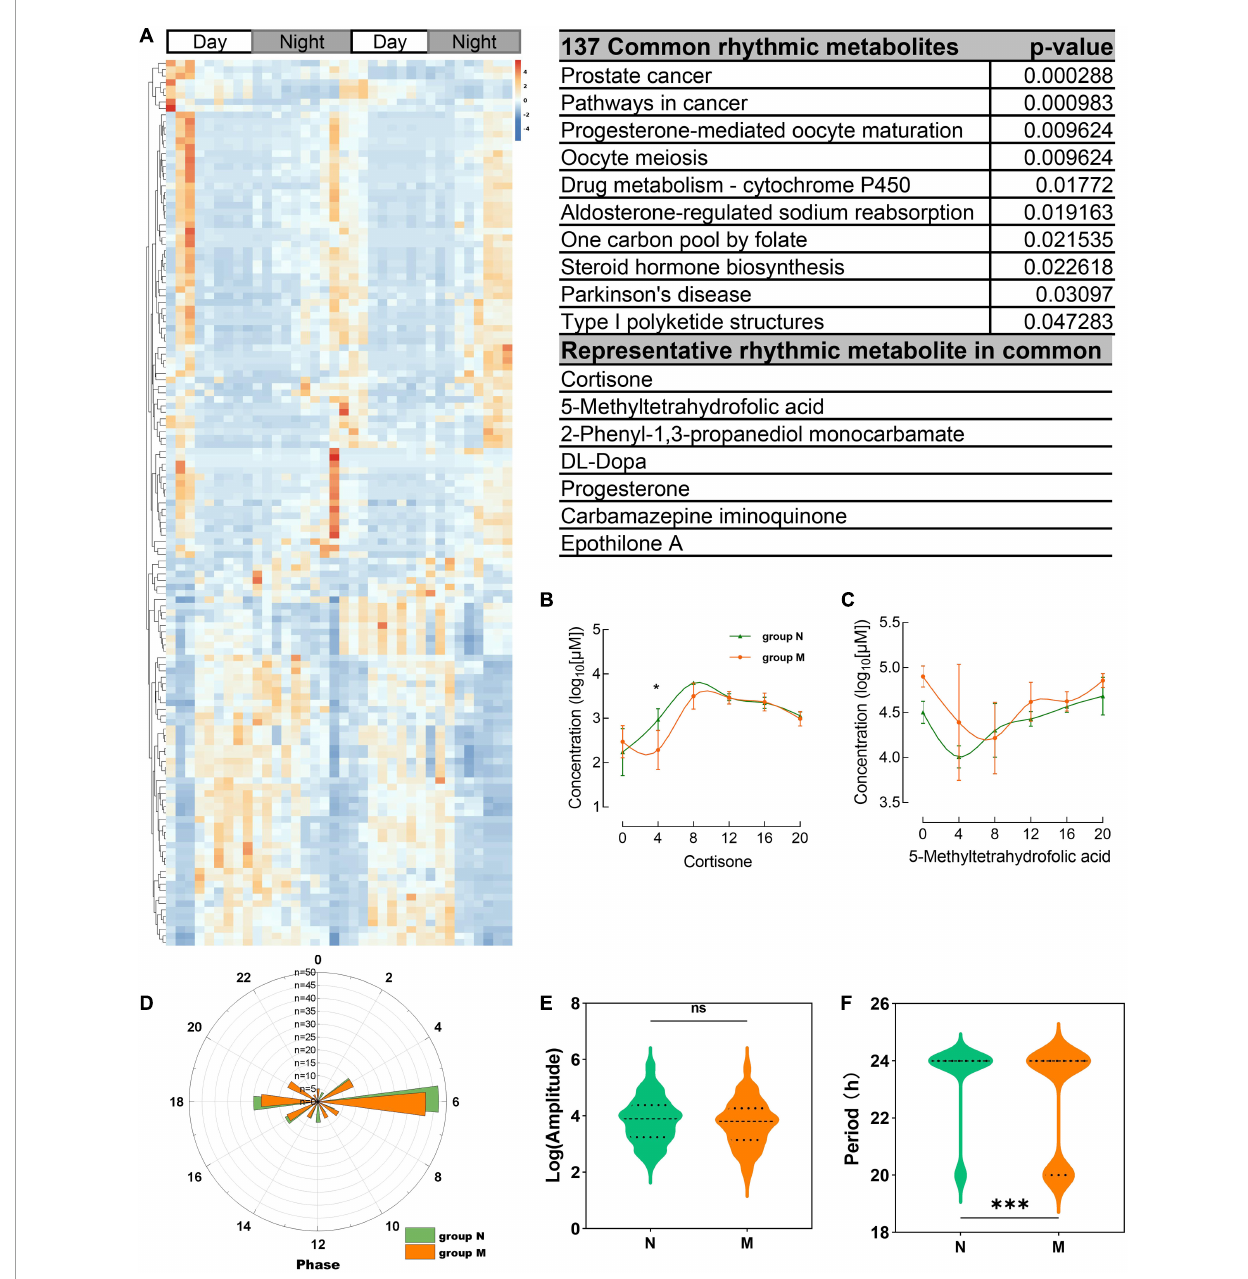
FIGURE4 Common shared rhythmic metabolites in group N and group M were identified from salivary samples. (A) The heatmap of common saliva metabolites with circadian rhythm and KEGG enrichment pathway and representative metabolites were shown. (B,C) The concentration of representative common rhythmic metabolites cortisone, 5-methyltetrahydrofolic acid. (D–F) The disruption phrase, amplitude and period of common shared rhythmic metabolites. * p <